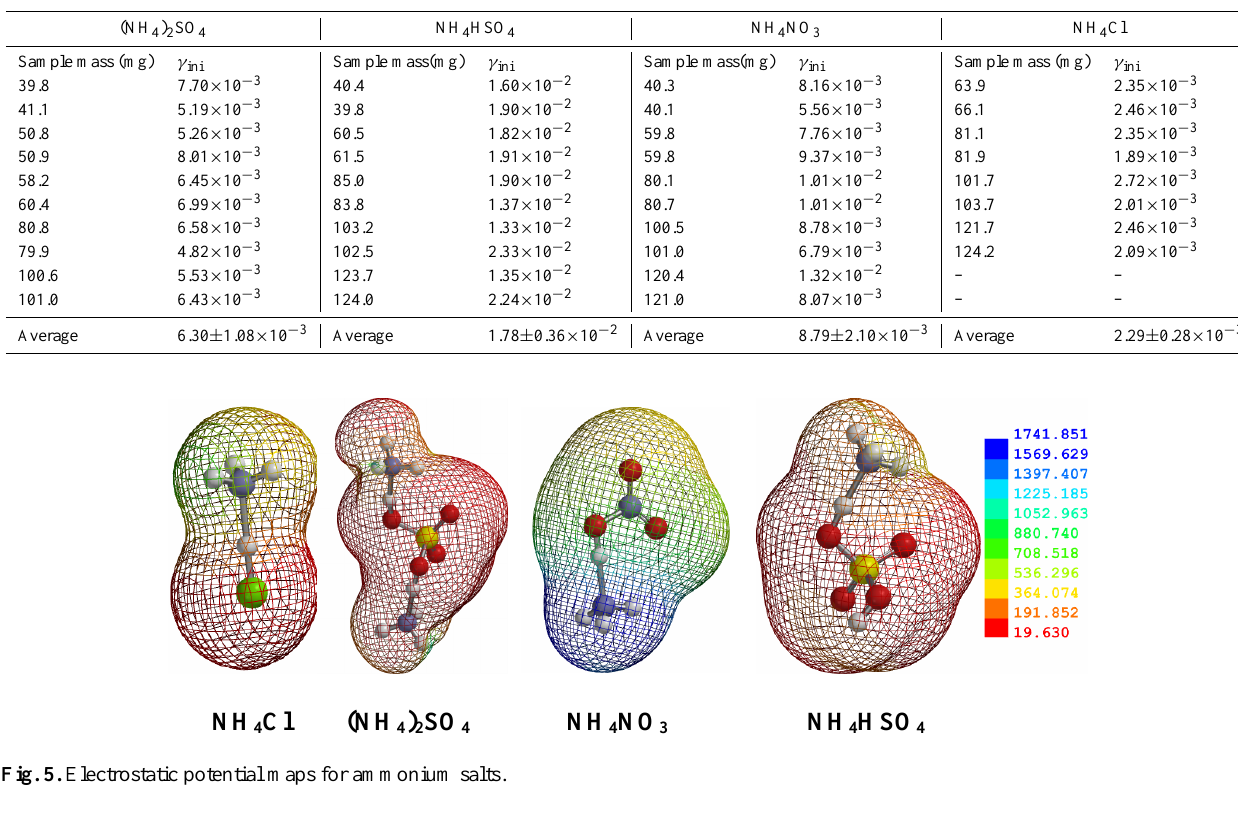
Table 1. Uptake coefficients of MA onto ammonium salts at 298K.